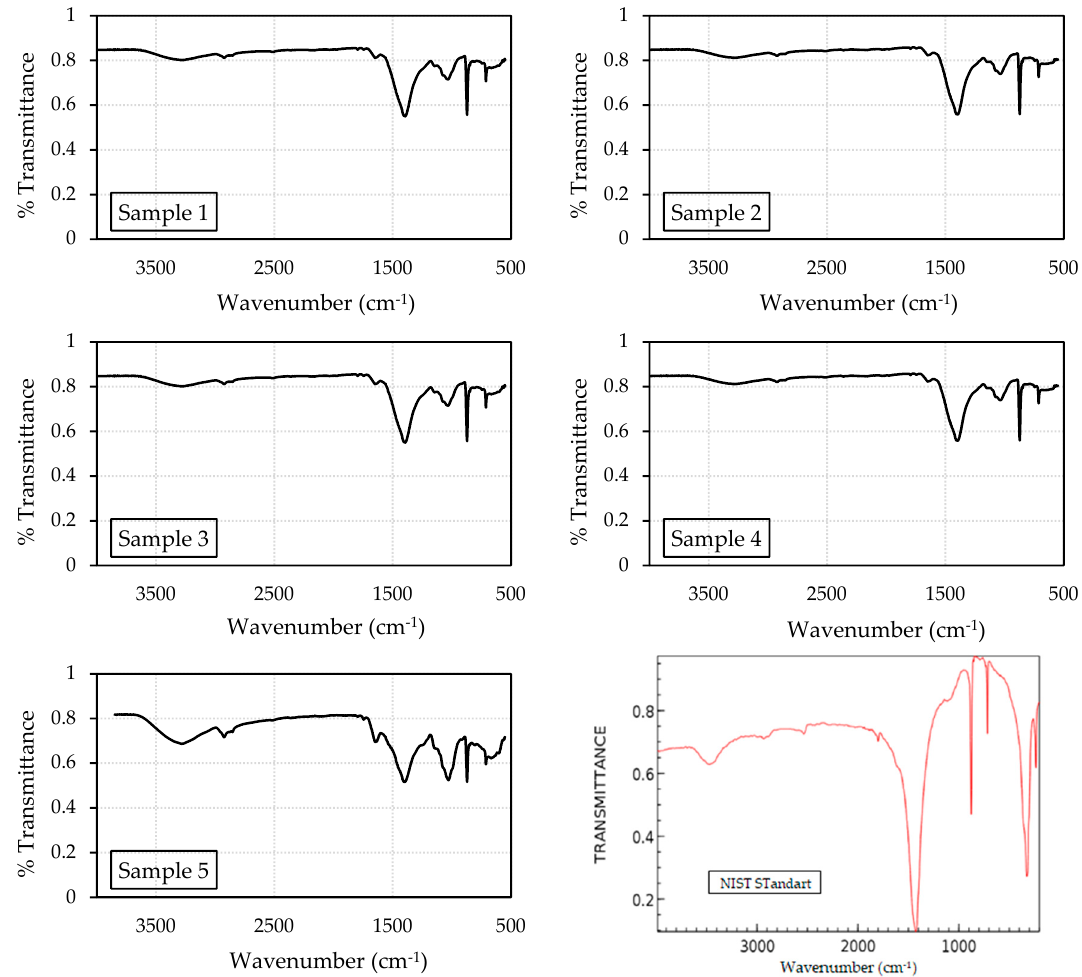
Figure 8. Spectra of FT-IR analysis of five different sample and standard spectra from NIST [33]. The same precipitates were examined by XRD to confirm the polymorph as crystals. The sample 1 precipitate XRD pattern is presented in Figure 9.